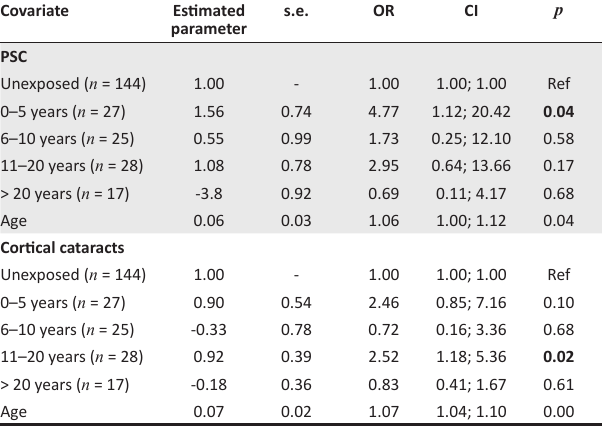
TABLE 5: Estimated radiation workload exposure in Gy.cm 2 for each category of worker without PPE protection and with the different PPE used. Covariate Radiologists Cardiologists Paediatric